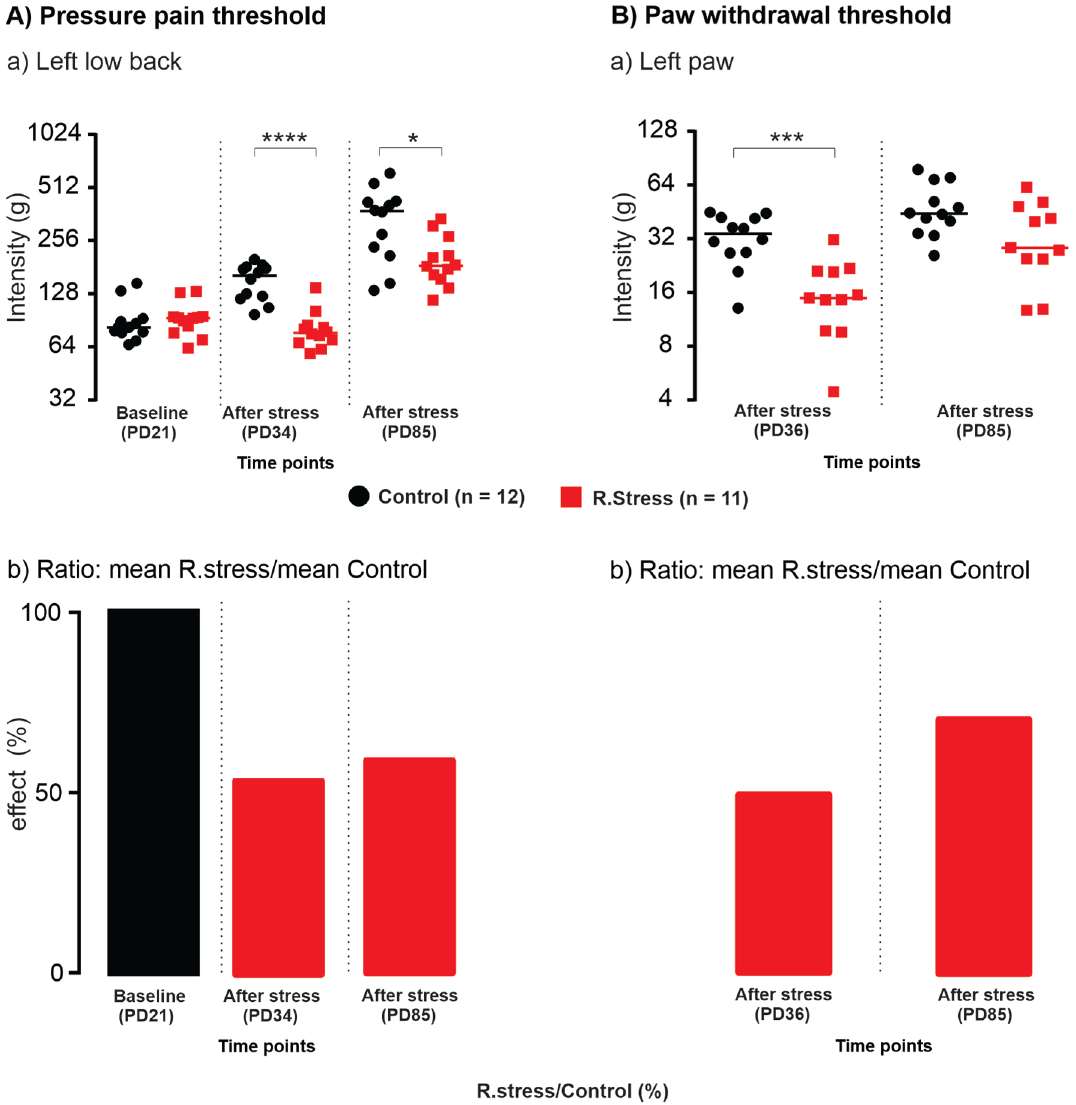
Figure 2. Pressure pain threshold and paw withdrawal threshold before and after stress. Repeated restraint stress in early adolescence induces long-lasting local muscle hyperalgesia and remote cutaneous hyperalgesia compared with non-stressed controls. ( A.a ) Individual data points expressed in log scale, force (in ‘g’ on the left y-axis) required to elicit a pain-related reaction (withdrawal behavior, escape movements, vocalization) using a blunt probe with an area of 3.46 mm 2 when applied to the left multifidus muscle of the low back. Horizontal lines indicate the median for each group. ( A.b ) Ratio (in ‘%’) of mean pressure pain threshold R.stress/control. ( B.a ) Individual data points expressed in log scale, force (in ‘g’ on the left y-axis) required to elicit a pain-related reaction (paw licking, paw withdrawal) using a rigid cylindrical tip with an area of 0.8 mm 2 when applied on the plantar surface of the left hind paw. Horizontal lines indicate the median for each group. ( B.b ) Ratio (in ‘%’) of mean paw withdrawal threshold R.stress/control. PD, postnatal days (see Fig. 1A). P -values: U -test of Mann and Whitney; P < 0.05 is represented with (*), P < 0.006 (**), P < 0.0001 (***), and P < 0.0001 (****), asterisks (*) represent the difference between the groups (stress vs.